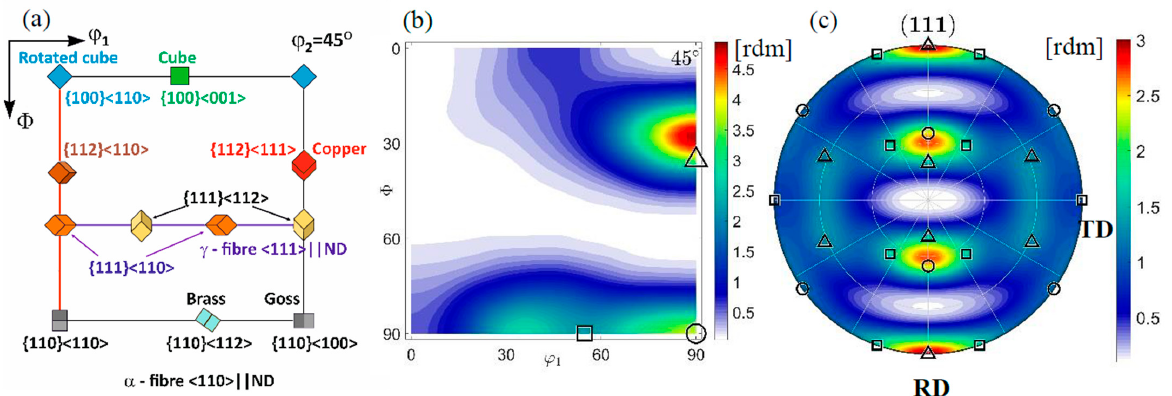
Figure 5. Initial texture: ( a ) key components and fibres in the section of Euler angle space at ϕ 2 = 45 ◦ ( b ) ODF with Brass (square), Goss (circle), Copper (triangle) orientations. The function values constitute multiples of a random misorientation (rdm). ( c ) {111} pole figure. ND, TD, and RD denote normal, transverse and rolling directions, respectively.